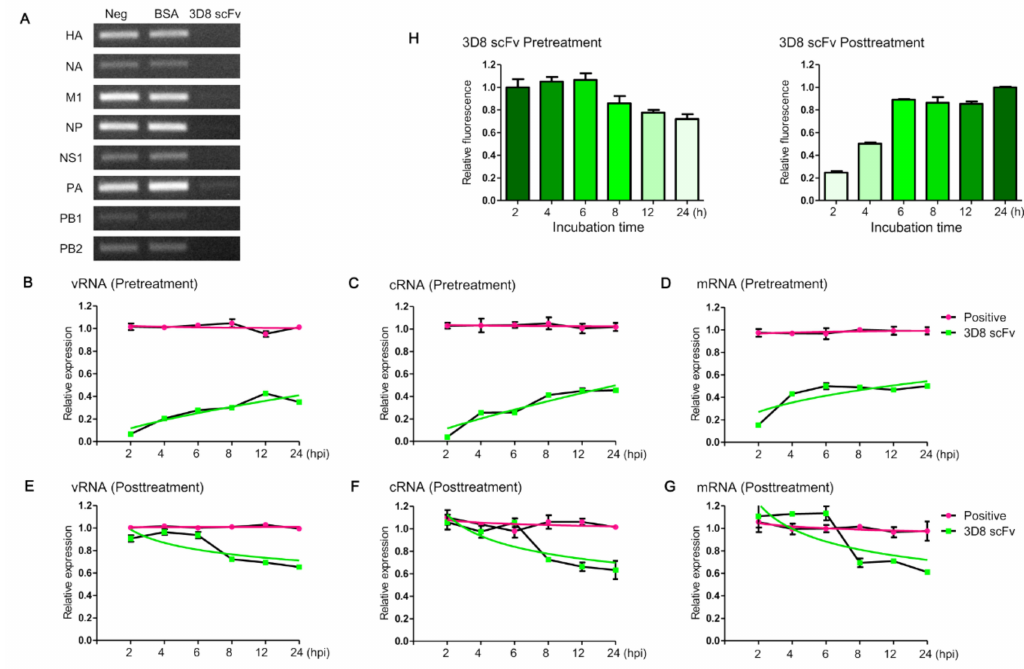
Figure 2. Identification of the differences in antiviral mechanisms according to 3D8 scFv treatment methods. ( A ) 3D8 scFv hydrolyzes eight viral RNAs of the vRNP complex. Total vRNP isolated from the virus particles was incubated with 3D8 scFv for 1 h at 37 ◦ C, and then the reactions were amplified with the viral RNA specific primers. ( B – D ) The relative expression of vRNA, cRNA, and mRNA of viral HA in 3D8 scFv-pretreated MDCK cells. MDCK cells were incubated with 3D8 scFv (3 µ M) in advance of virus infection (MOI = 0.1), and qRT-PCR was performed to measure the relative expression of viral HA RNAs. ( E – G ) The relative expression of vRNA, cRNA, and mRNA of viral HA after virus infection in 3D8 scFv-posttreated MDCK cells. qRT-PCR was performed to measure the relative expression of viral HA RNAs. Data are shown as the mean ± S.E.M. of triplicate samples. ( H ) Changes in the amounts of 3D8 scFv in the cytoplasm according to 3D8 scFv pre- and posttreatment,